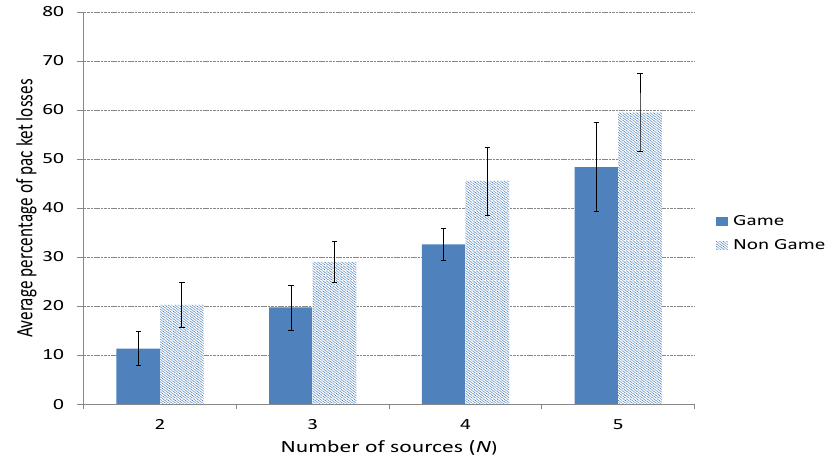
Figure 8. Average percentage of packet